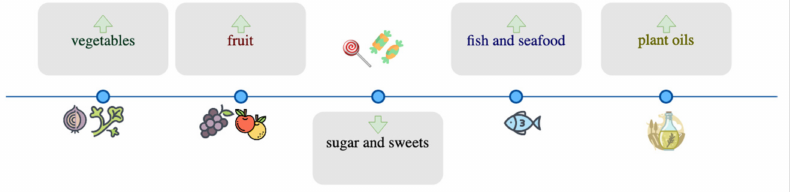
Figure 5. Shared food-group components of regional diets included in the present